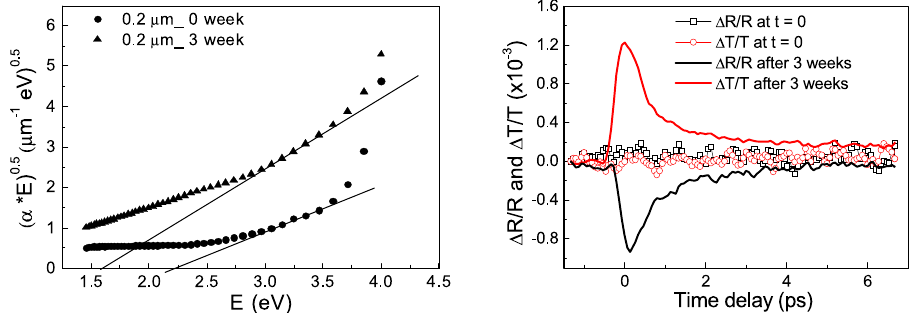
Figure 3. (left) Tauc plots obtained from absorbance measurements reported in Fig. 1, for the 0.2 µ m thin films at 0 week (black circles) and after 4 weeks (black squares); (right) pump-probe transient transmittivity, Δ T/T (red), and reflectivity, Δ R/R (black), for the sample with thickness of 0.2 µ m, measured at 0 week (open symbols) and after 4 weeks (solid